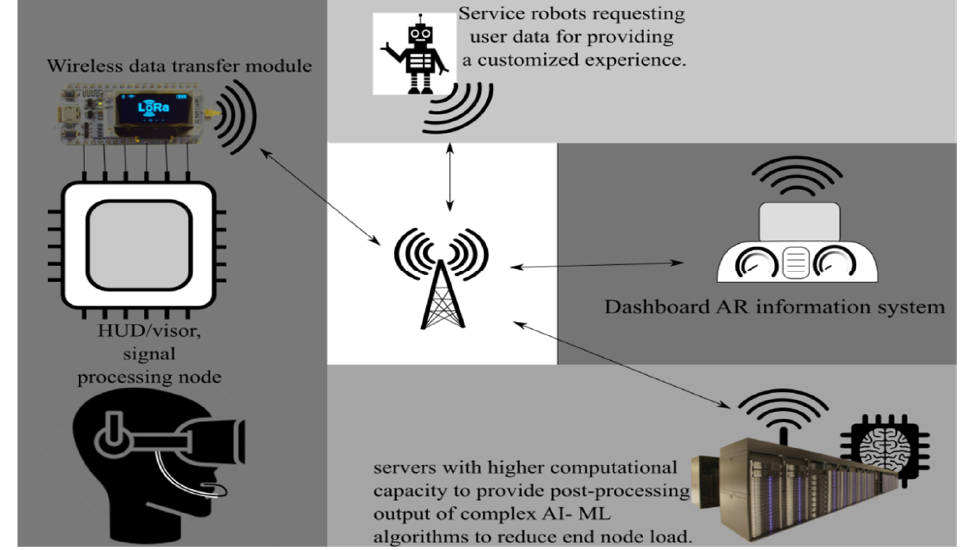
Figure 5. IoT coupled with AI–ML assisting AR modules with all five sensory data inputs.